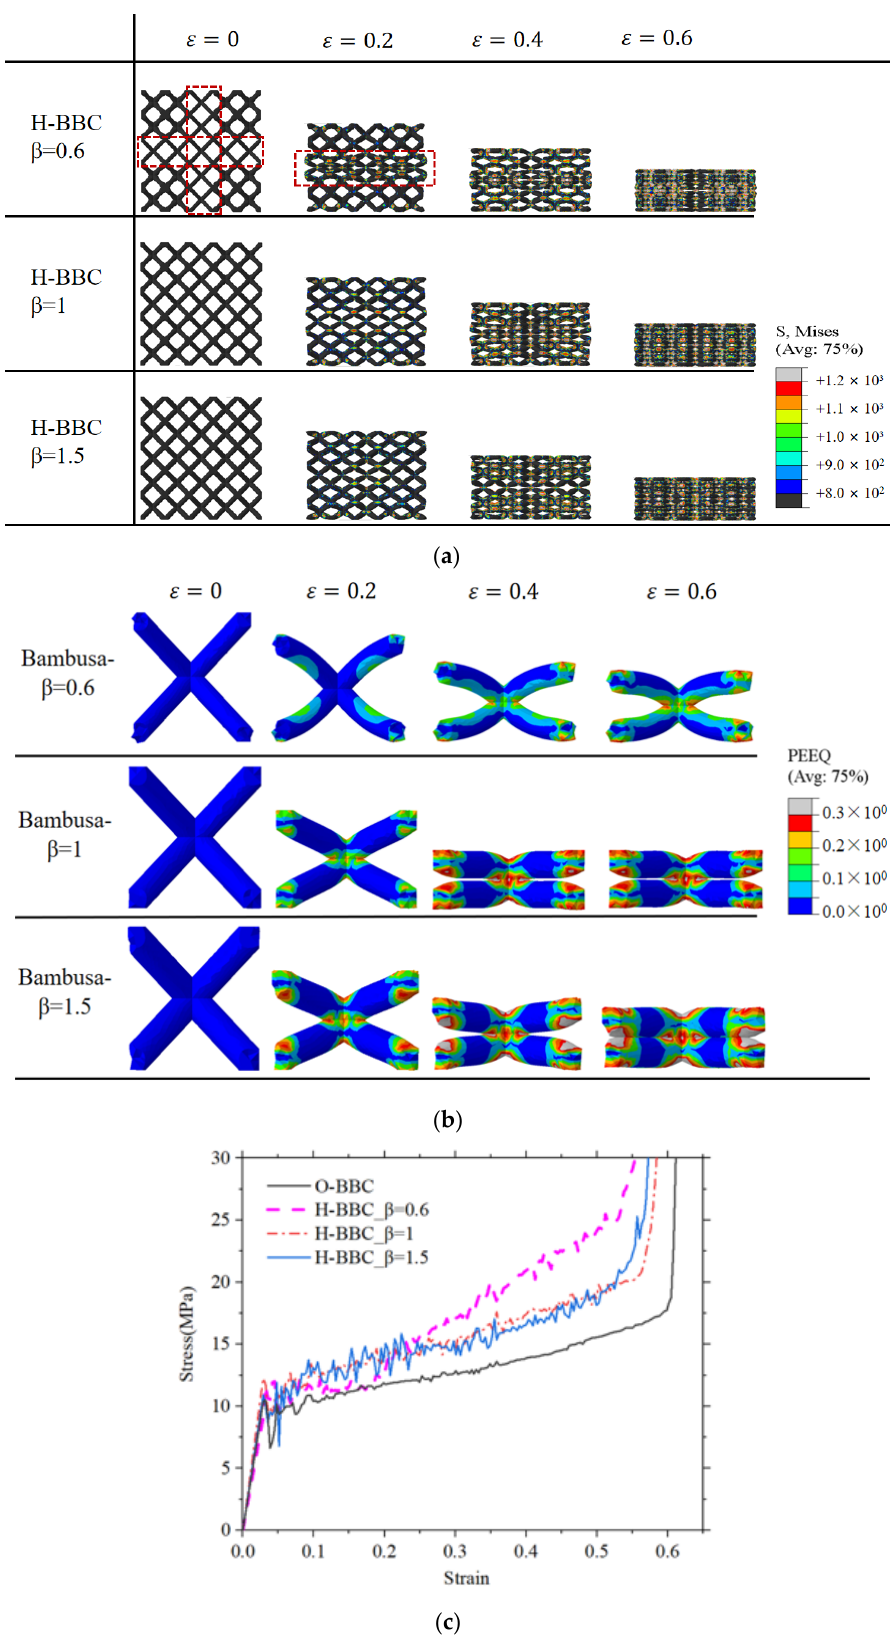
Figure 9. Compression characteristics of Bamboo-lattice structure: ( a ) deformation process in cross- sectional view; ( b ) middle unit cell in joint partition; and ( c ) stress–strain curve.